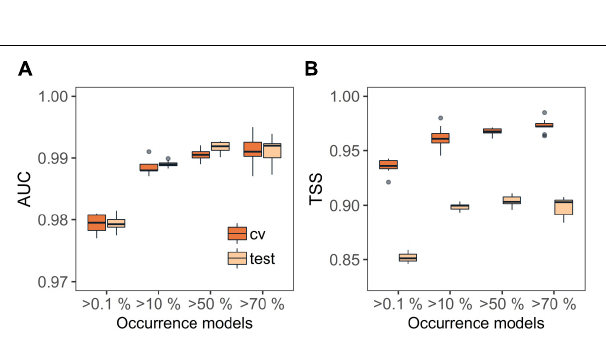
FIGURE 2 | Concretions found along the Finnish marine areas. Larger, light yellow points indicate areas of concretion fields ( > 70% coverages) and small, orange points of smaller concretion occurrences (0.1–10%).